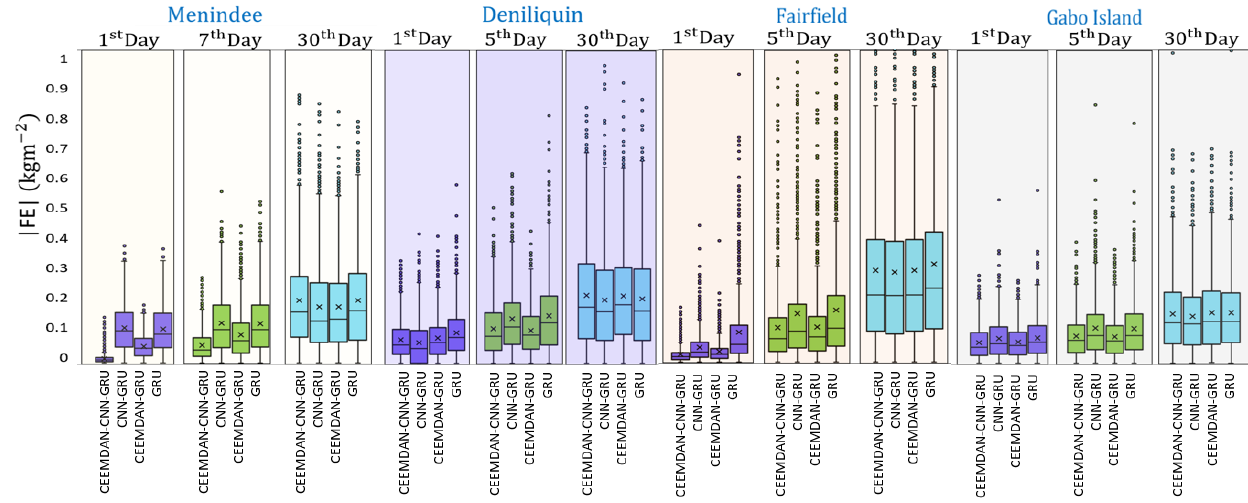
Figure 11. Box plot of errors in the testing phase for hybrid CEEMDAN-CNN-GRU against comparative models at different n th ( n = 1, 7, and 30) day ahead lead time forecasting SSM. (Note: CEEMDAN-CNN-GRU = Hybrid Model integrating the CEEMDAN and CNN algorithm with GRU; CEEMDAN-GRU = Hybrid Model integrating the CEEMDAN algorithm with GRU; CNN-GRU = Hybrid Model integrating the CNN algorithm with GRU) .